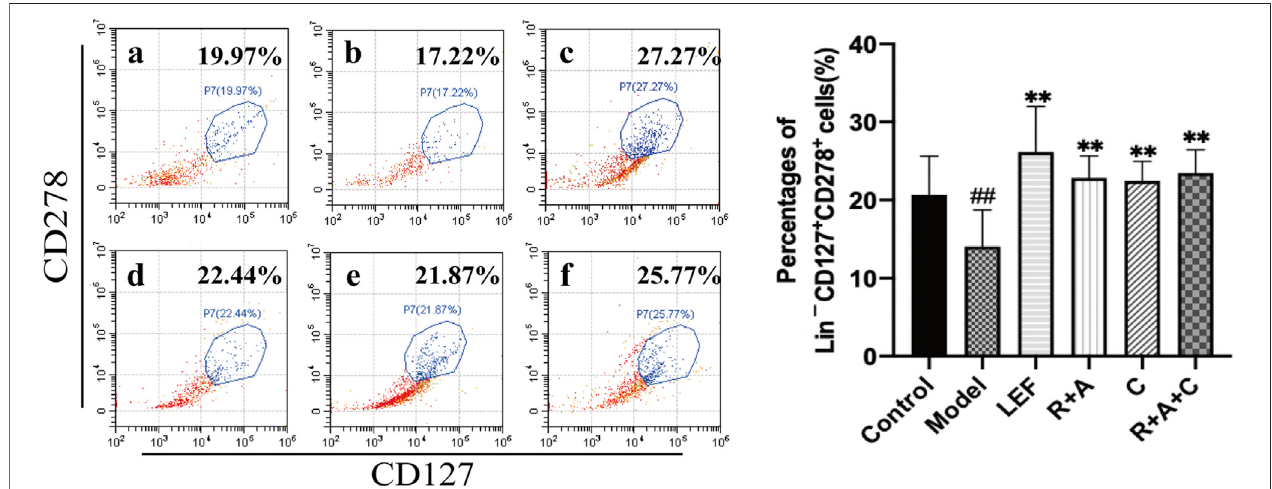
FIGURE 6 | The percentages of Lin − CD127 + CD278 + cells. (a) , control group; (b) , model group; (c) , LEF group; (d) , R . astragali + R . angelicae sinensis (R + A) group; (e) , C . lonicerae (C)group;and (f) , R . astragali + R . angelicaesinensis + C . lonicerae (R+A+C)group.Theresultsarepresentedinthebarcharts( n =8).Dataare presented as the mean ± SD ( n = 8); # p < 0.05, ## p < 0.01, compared with the normal group; * p < 0.05, ** p < 0.01, compared with the model group.